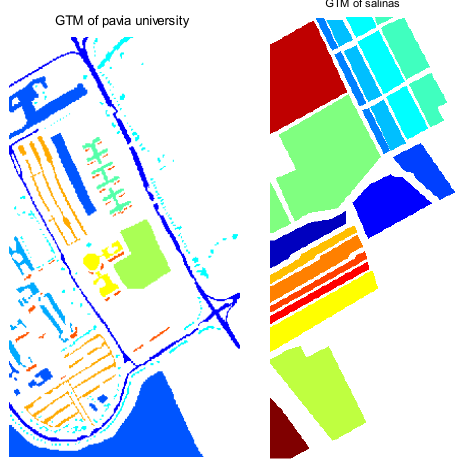
Figure 2. GTM of Pavia university and Salinas